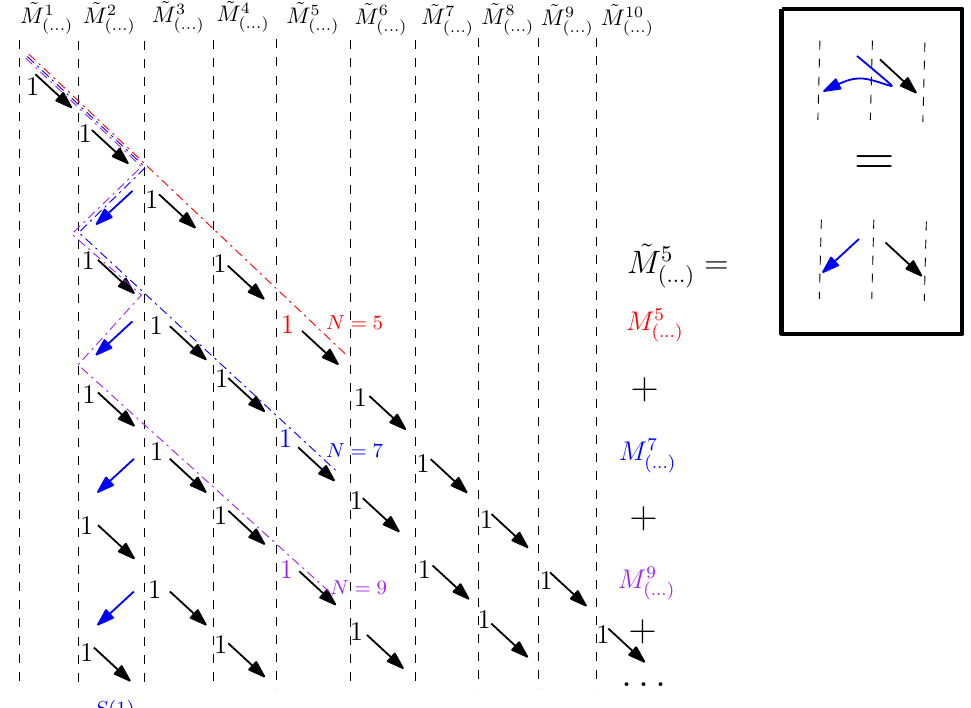
Figure 13. Numbers near vertices of the lattice are the coefficients in Figure 12. Blue arrows denote steps in the recursion, which were added by the long steps S ( 1 ) in the lattice path model. Length of paths N , descending to a considered vertex of a lattice gives the number of the strip in the auxiliary lattice path model, the multiplicity function of which is being added to (32) as a term. As an example, | we show formula for ˜ M 5 k = 1 ( M , N )